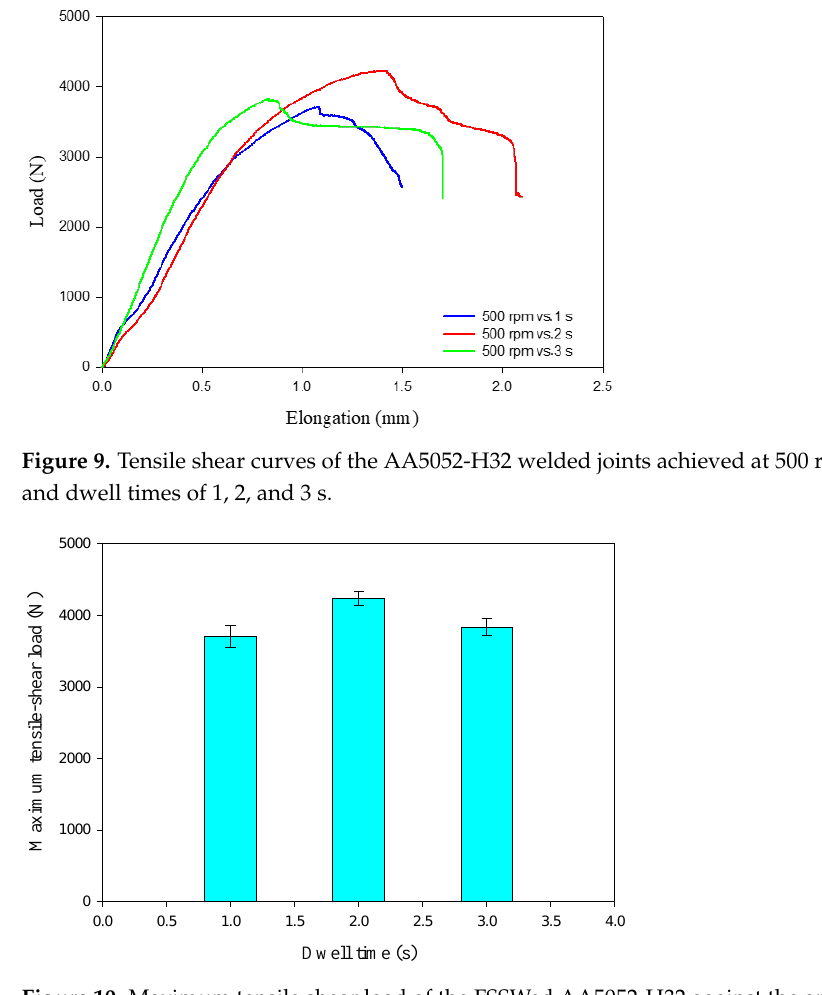
Figure 10. Maximum tensile shear load of the FSSWed AA5052-H32 against the applied dwell times. Based on the results of two different applied tension tests (cross-tension test and